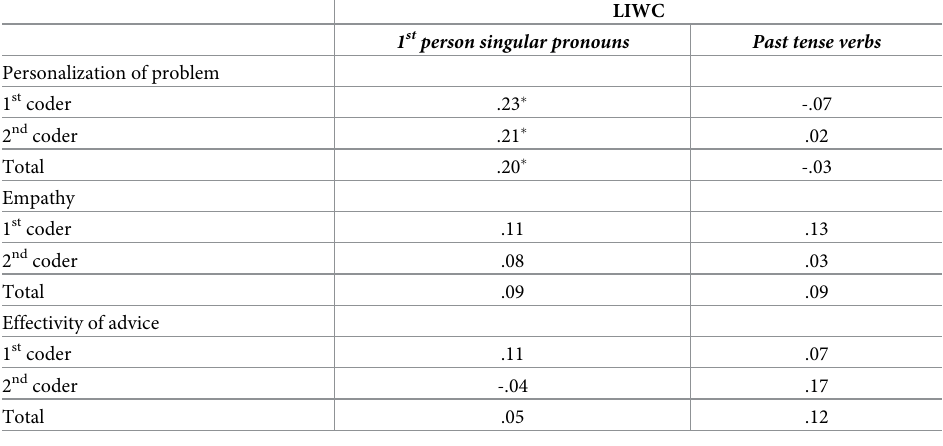
Table 5. Correlations between LIWC measures and the coders’ assessments on each scale in the interpersonal problem-solving study–Spearman’s coefficient ( N = 109).